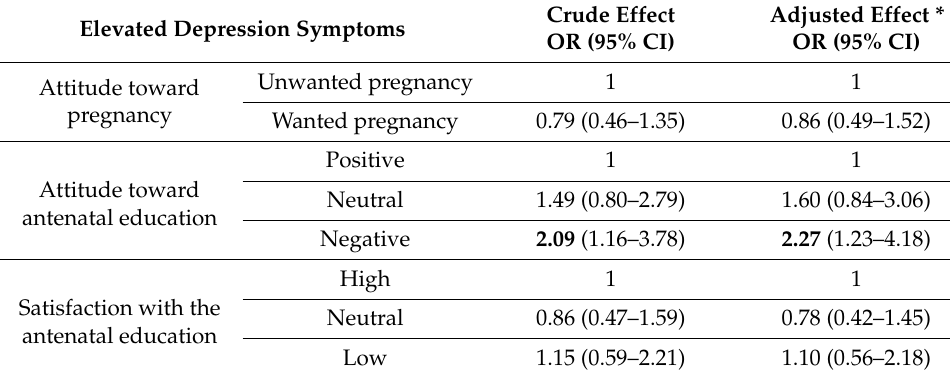
Table 4. Logistic regression analysis- risk of having higher levels of postpartum depression symptoms in groups with regard to antenatal education and attitudes toward